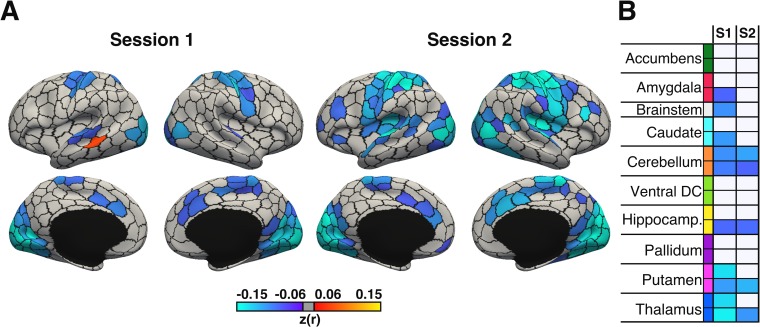
BOLD signal fluctuation is negatively correlated with time of day across cortical and subcortical regions during session 1 (n = 942) and session 2 (n = 869).Between-participant correlations between time of day and BOLD signal fluctuation for (A) 400 cortical and (B) 19 subcortical regions of interest. With the exception of brainstem, all subcortical regions are bilateral and presented as left-to-right hemisphere pairs (top to bottom). Colours (cool–warm) denote brain regions with significant Pearson r coefficients (q < 0.05, FDR-corrected), whereas nonsignificant regions are shown in grey. p-Values were derived from 100,000 permutations while keeping family structure intact [40]. BOLD, blood oxygen level–dependent; ventral DC, diencephalon; FDR, false discovery rate; Hippocamp., hippocampus; S1, session 1; S2, session 2.